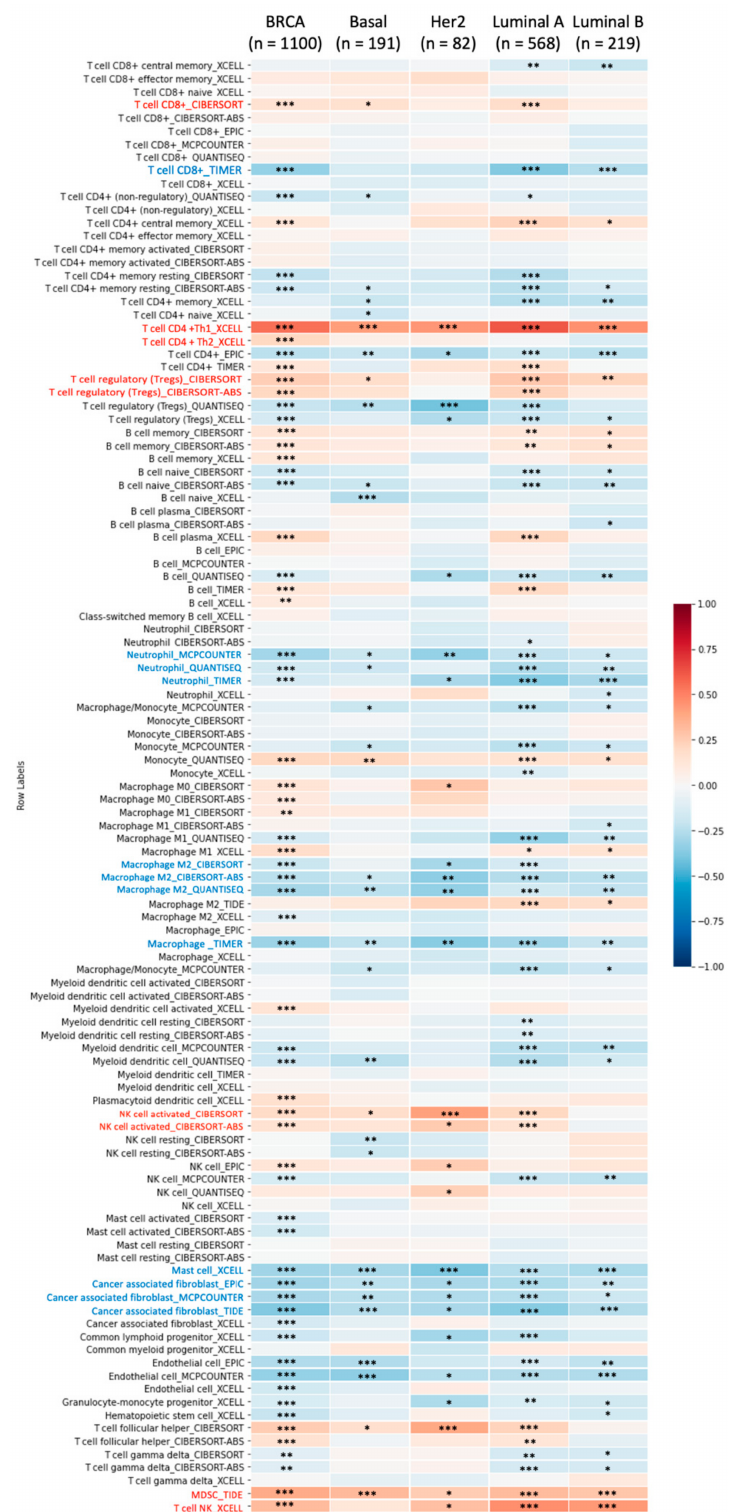
Figure 6. Heatmap of LSM4 expression and immune infiltrates in various breast cancer subtypes. The plot indicates correlations of breast cancer subclasses (basal, HER2, luminal A, and luminal B) and the number of samples out of 112 immune infiltrates methods from six state-of-the-art algorithms, consisting of TIMER, EPIC, CIBERSORT, xCell, MCP-counter, and quanTIseq. R-scores ranged − 1.0–1.0. A value of r = 1 denotes a perfect positive correlation, while a value of r = − 1 shows a perfect negative correlation. (* p < 0.05, ** p < 0.01, *** p <